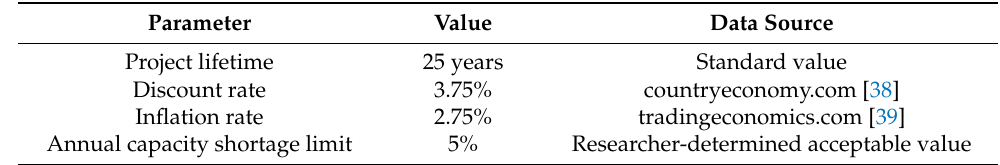
Table 4. Parameters used in the HOMER Pro design and techno-economic